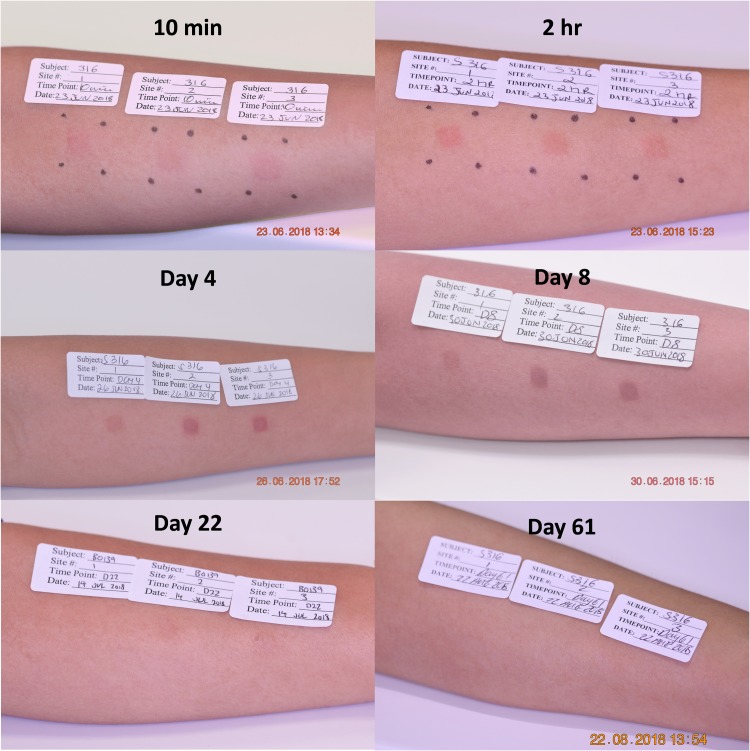
Representative images of skin reactions over time at HD-MAP application sites (single participant (S316/B0139), MAP-FA-10 group).Photographs show 3 HD-MAPs applied to adjacent sites on the forearm; site 1 (nearest the elbow crease) is the uncoated patch, and sites 2 and 3 are applications of the A/Sing coated HD-MAPs delivering 5 μg HA into the skin per patch. Timepoints at 1 h and 24 h are not shown in the image sequence. Photo credit Nucleus Network Pty Ltd. A/Sing, A/Singapore/GP1908/2015 H1N1; FA, forearm; HA, haemagglutinin; HD-MAP, high-density microarray patch; MAP, microarray patch.